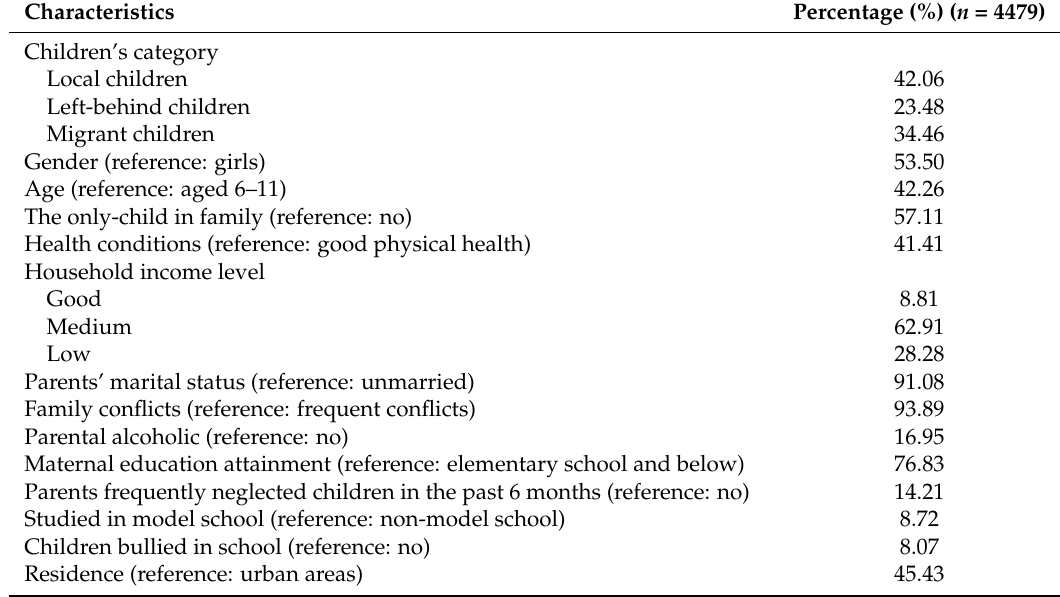
Table 2. Characteristics of